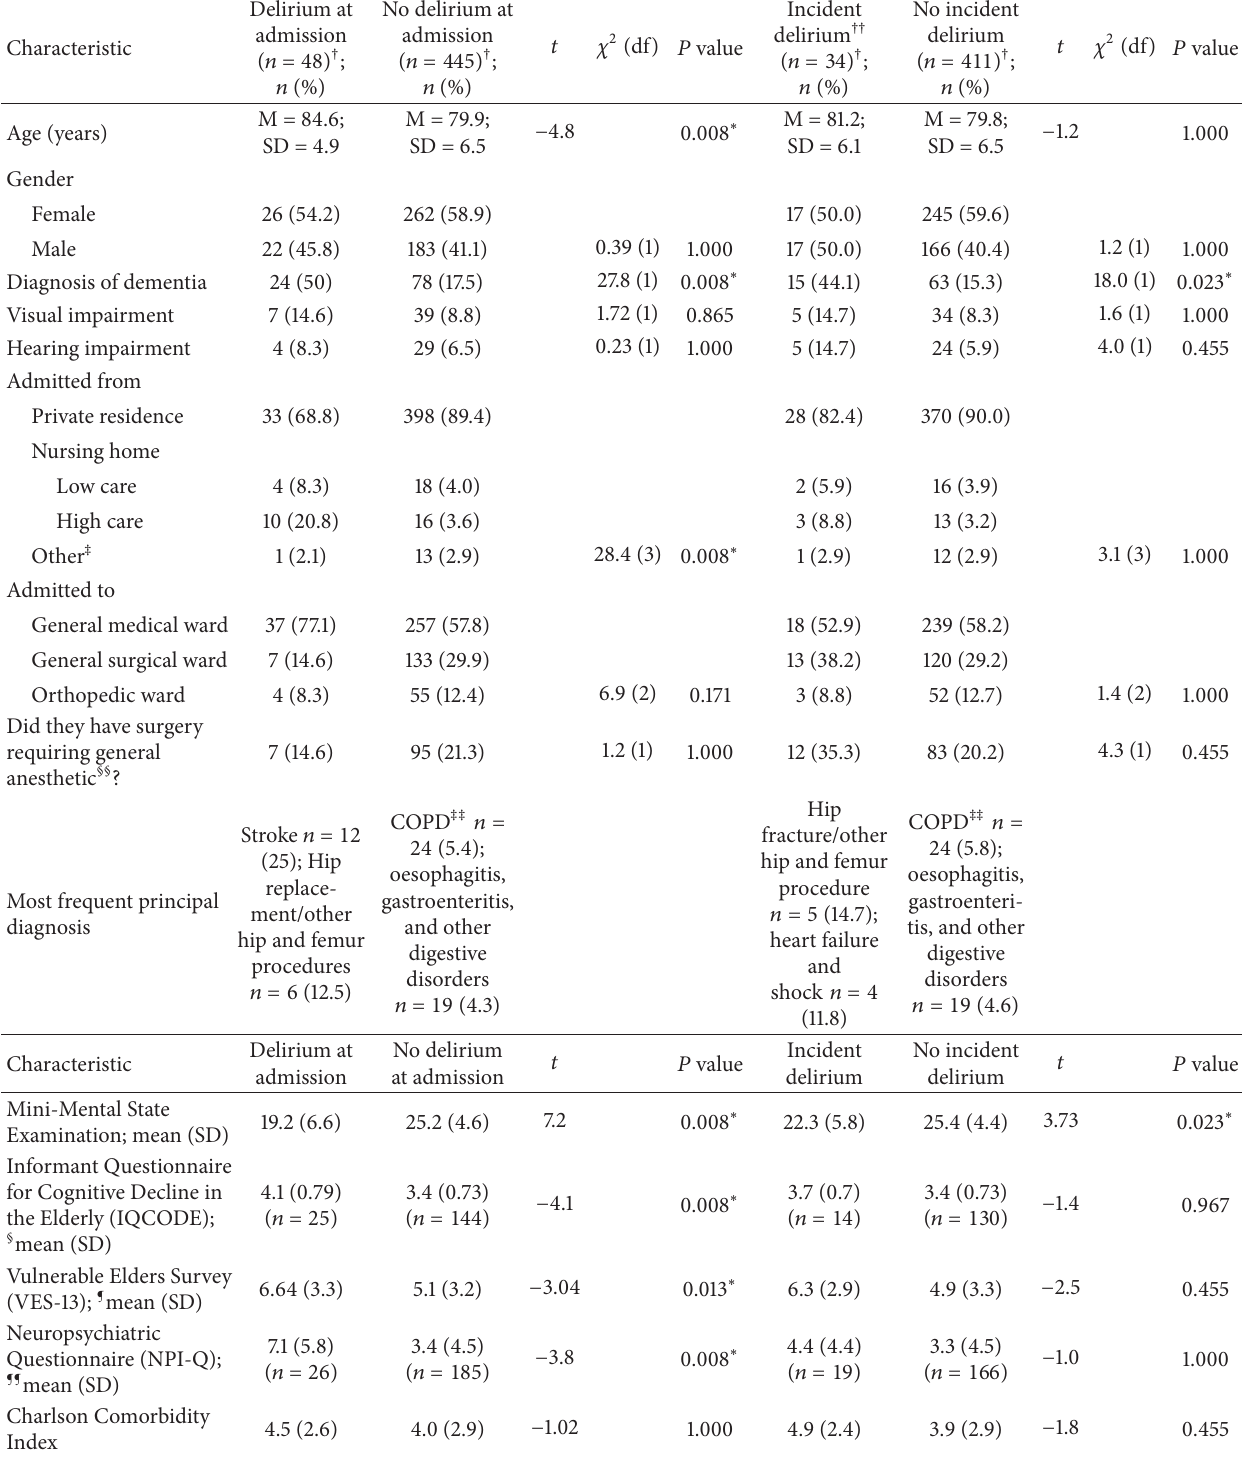
Table 1: Demographic and clinical characteristics and assessment results of patients with delirium versus those without delirium.